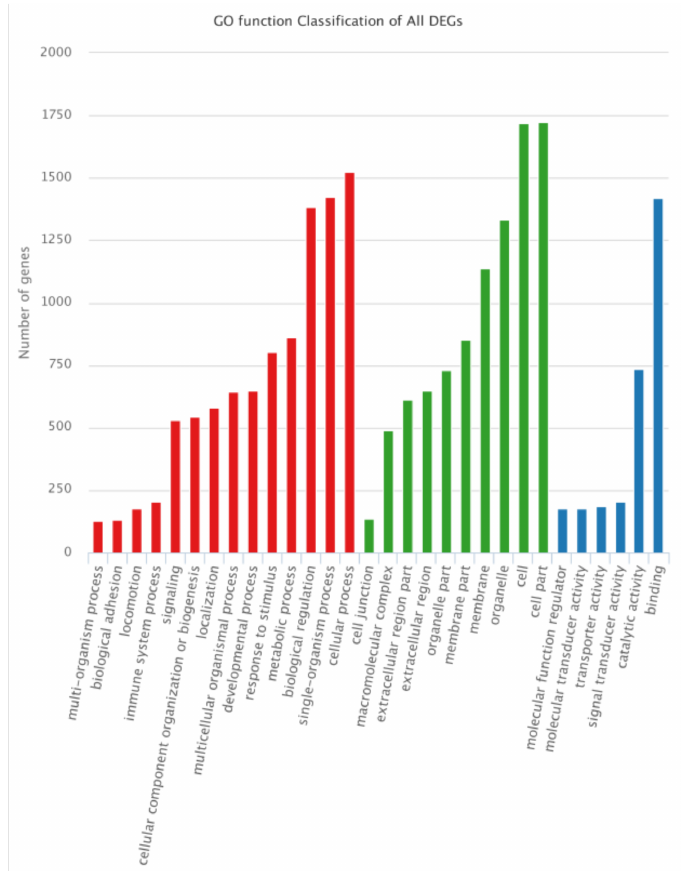
Figure 4. GO classification of all DEGs. For GO annotation, the abscissa is the GO term, and the ordinate indicates the number of DEGs annotated to GO